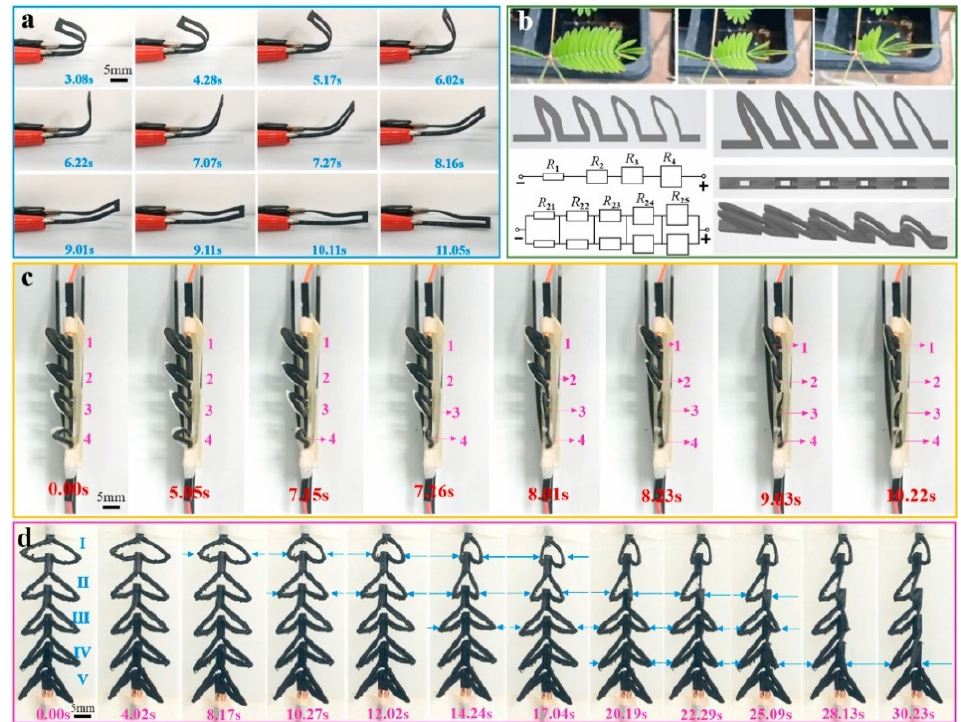
Figure 14. 4D printing of electroactive shape-changing samples. ( a ) Shape-changing behavior when exposed to 200 V DC electrical stimuli; ( b ) Design and circuit design of biomimetic mimosa leaves; ( c ) Single-row demonstration of biomimetic mimosa leaves, and ( d ) Double-row demonstration of biomimetic mimosa leaves. Reproduced with permission from [233]. Copyright (2021) Elsevier.